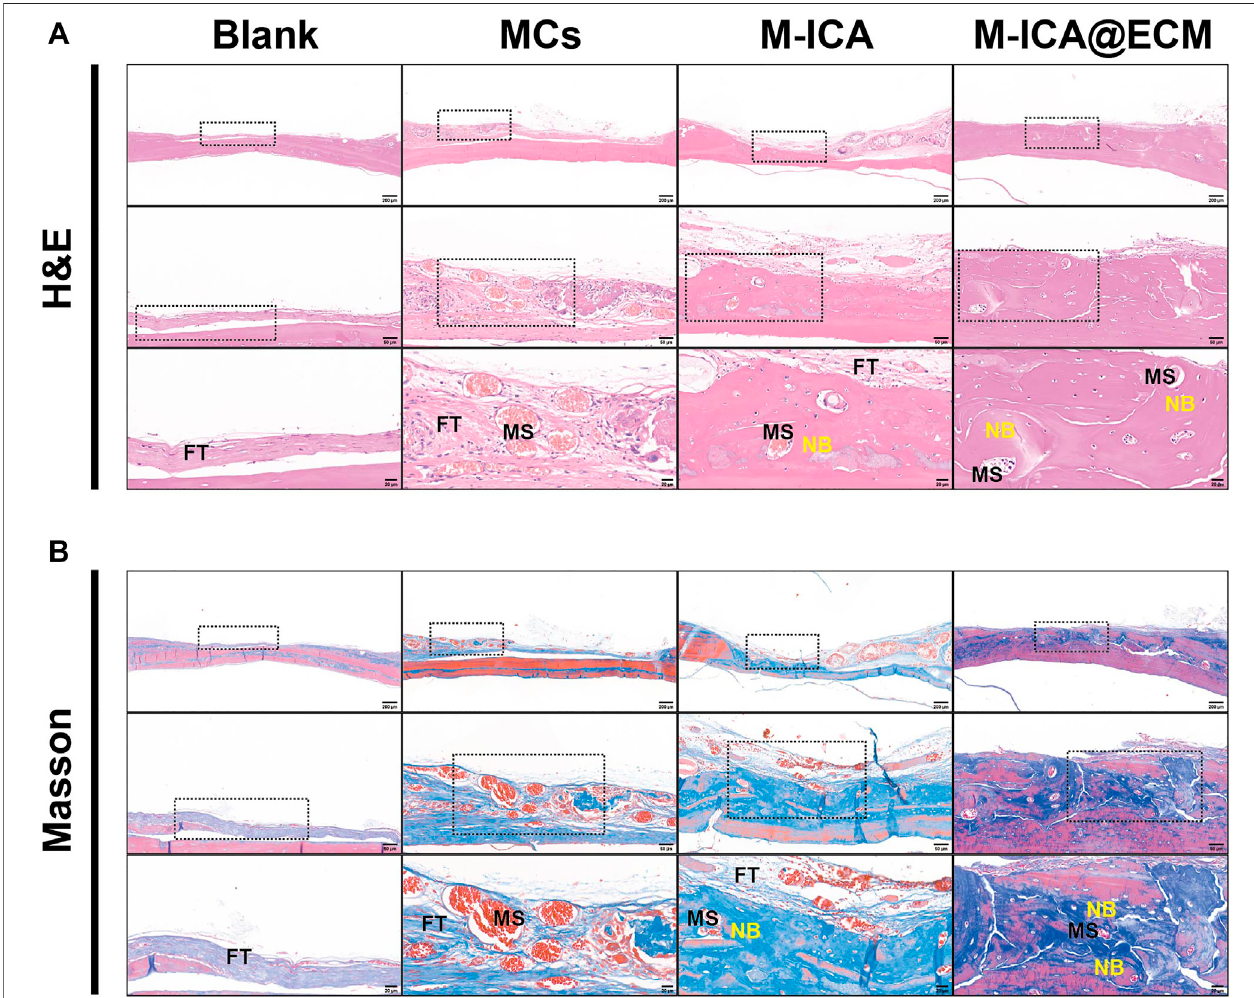
FIGURE 10 | H&E staining (A) and Masson staining (B) in rat calvarial bone defects at 8 weeks after surgery. FT: fi brous tissue; MS: microcarriers; NB: new bone.